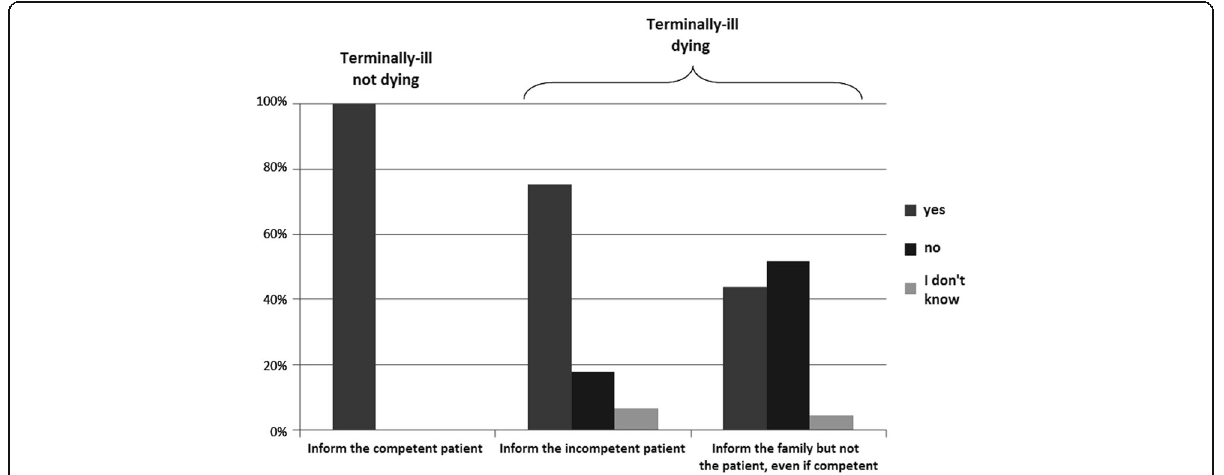
Fig. 1 Graph of Terminal patient answeres. Legend: Percentage of answeres related to terminal patient (dying and not-dying)